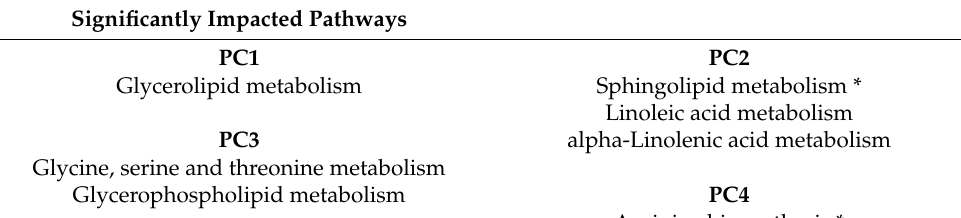
Table 3. Metabolic pathways represented in the first four components identified with principal